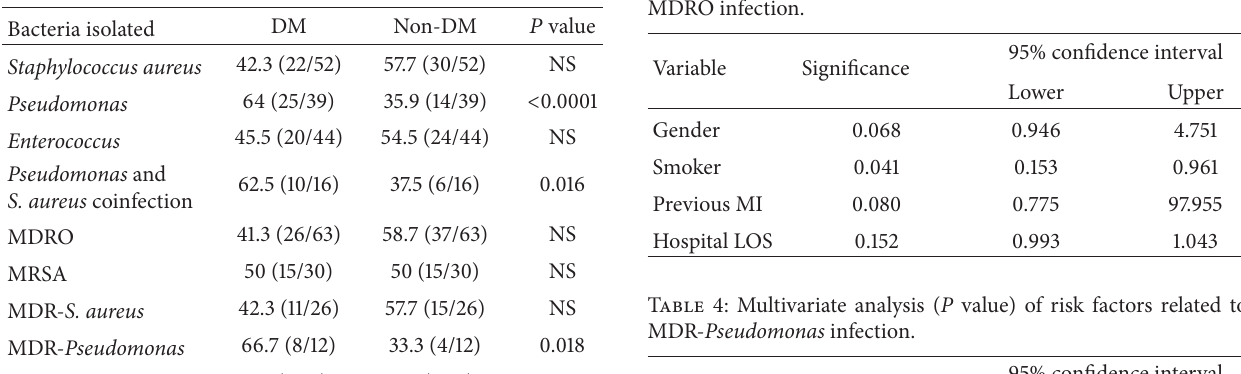
Table 2: Bacteria isolated from wounds.